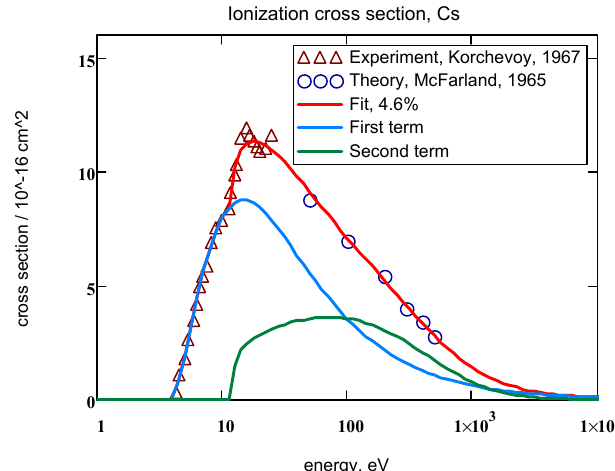
Figure 5. Experiment [11,28] and the result of approximation by the two − term Formula (7) of the ionization cross section of cesium atoms with a mean square relative error of 4.6%.